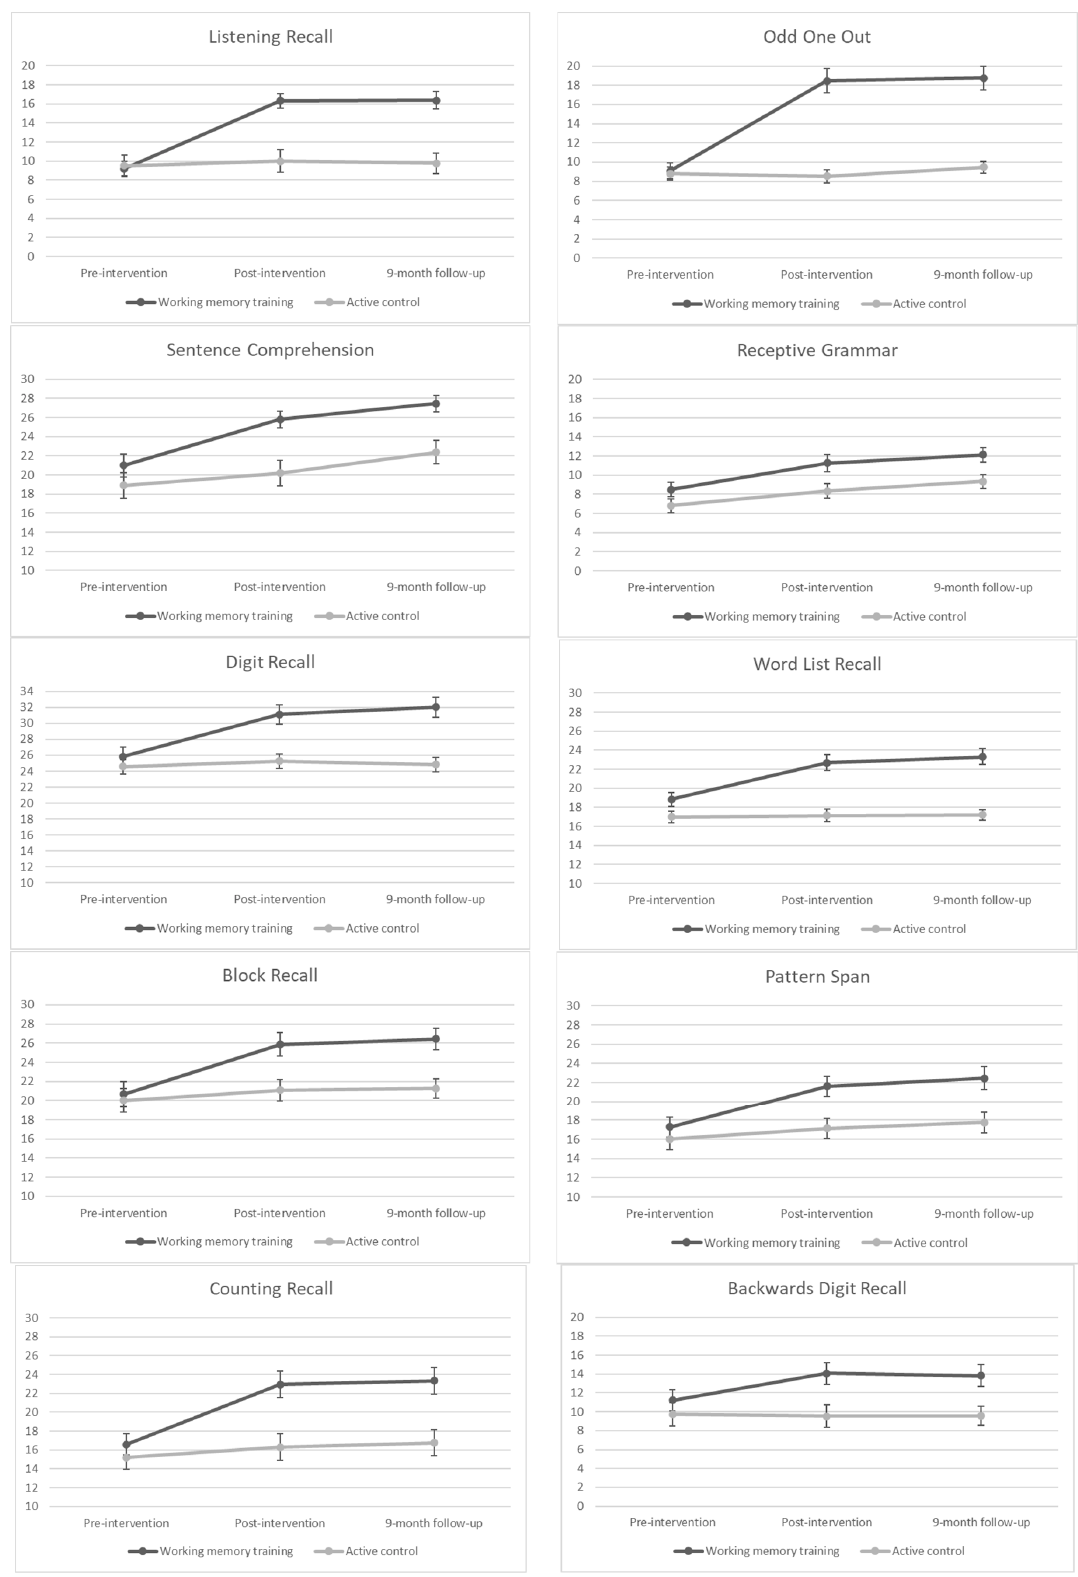
Figure 2. Graphs illustrating raw scores on all outcome measures (with standard error bars) at pre-intervention, post-intervention and 9-month follow-up for both groups (working-memory training and active control).